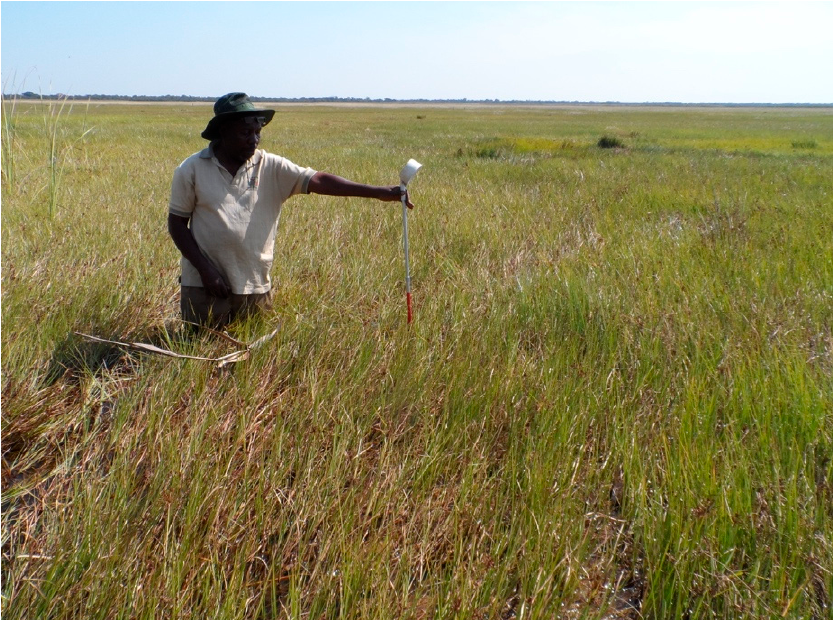
Figure 10. Example vegetated water body that was missed by the classification, characterised by dense grasses. Image from June 2018 long: 23.4, lat: − 14.8. Ranging pole with 5 × 20 cm sections from base. Water depth = 40 cm.